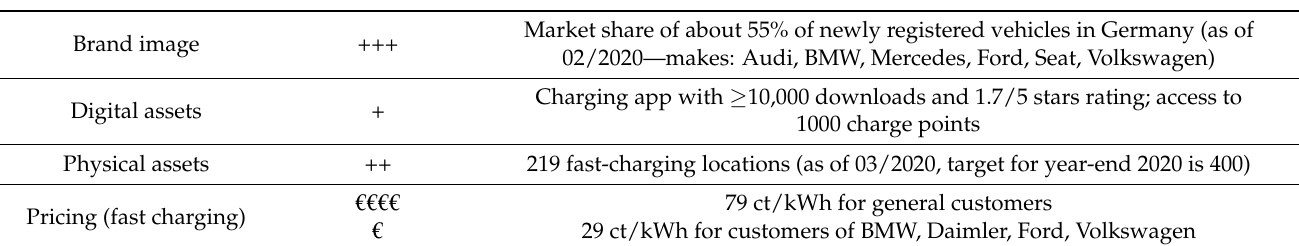
Table 9. Analysis of Ionity